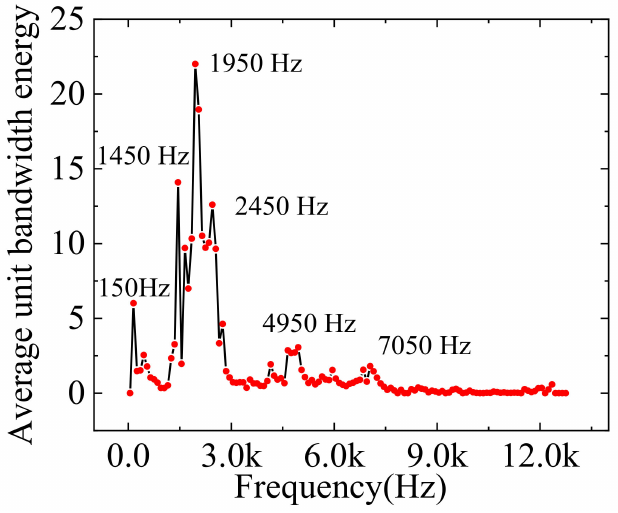
Figure 3. Frequency domain distribution of unit bandwidth energy of engine